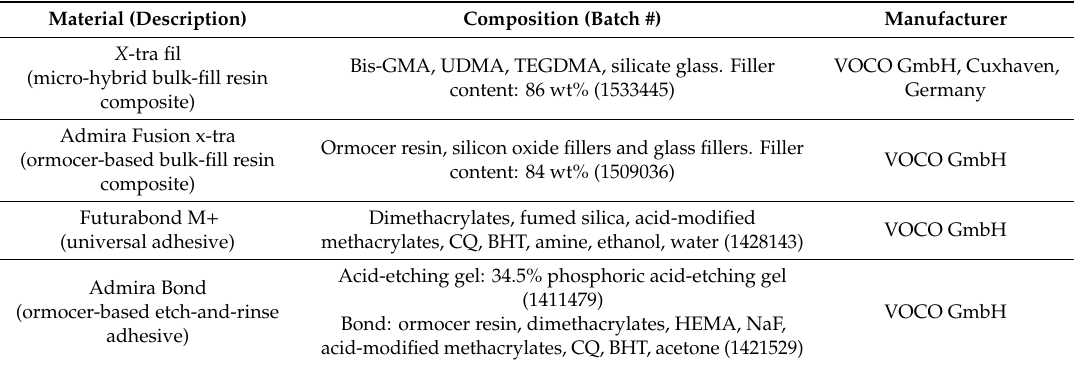
Table 1. Materials (description), composition (batch #) and